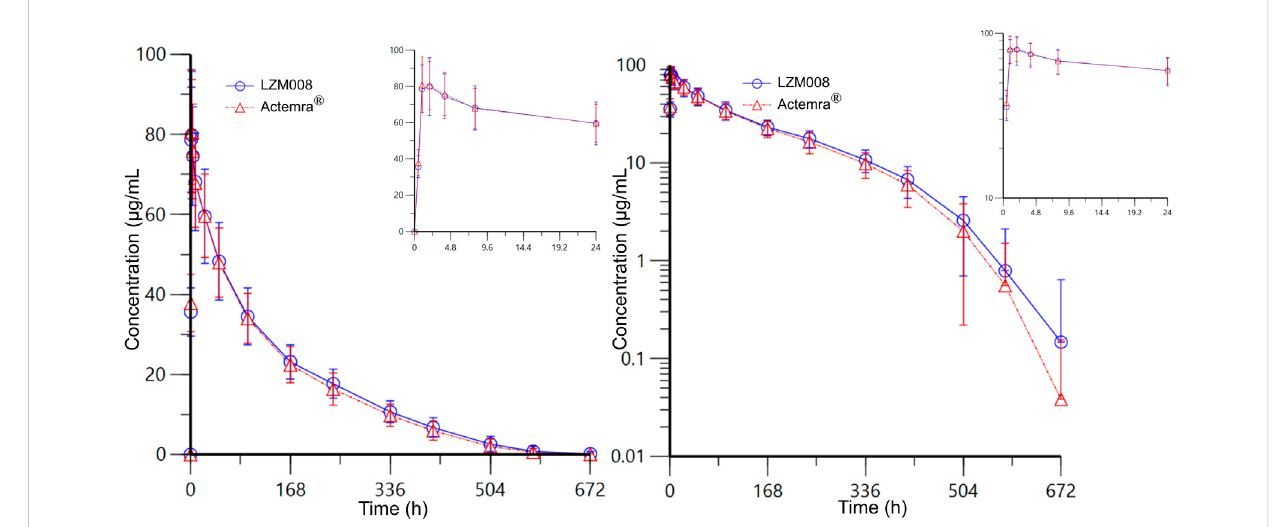
FIGURE 2 Mean serum concentration – time pro fi les for LZM008 and ACTEMRA ® . Note for Figure 2: the error bars represent standard deviation.